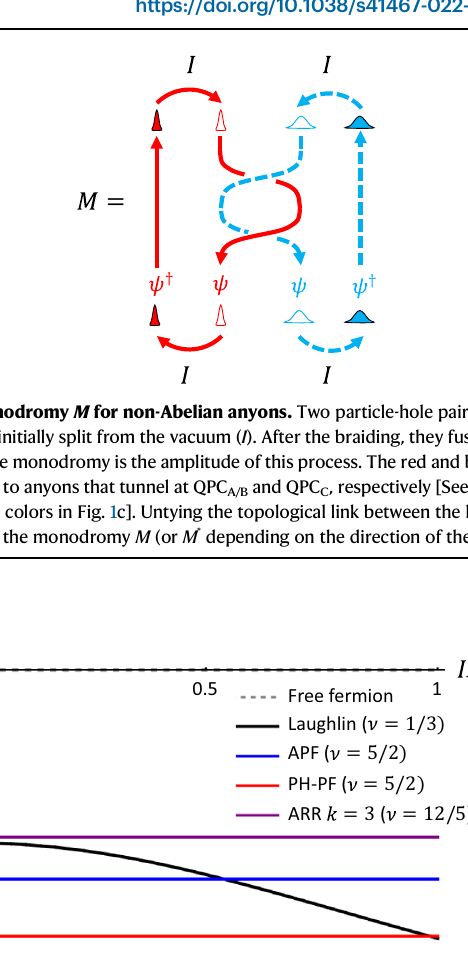
Fig. 4 | Dependence of Fano factor P ref on I − / I + for various anyons. The Fano factors are shown for free fermions (gray dashed), Laughlin anyons at ν =1/3 (black),anti-Pfaf fi anstate at ν =5/2 (APf, blue),particle-hole Pfaf fi anstate at ν =5/2 (PH-Pf, red), and anti-Read-Rezayi state at ν =12/5 (ARR,purple).Atany value of I − / P − 1 for the anti-Pfaf fi an state, P − π /4 for the particle-hole Pfaf fi an state, I ffiffiffiffiffiffiffiffiffiffiffiffiffiffiffiffiffiffiffiffiffiffiffiffiffiffiffiffi ffiffiffi p p + , ref = ref = = 4 π ’ (cid:3) 0 : 8 for the anti-Read-Rezayi state. The and P ref = (cid:3) 5 250 (cid:3) 110 5 behaviors of the non-Abelian anyons are distinguished from free fermions with P ref =0 and the Abelian